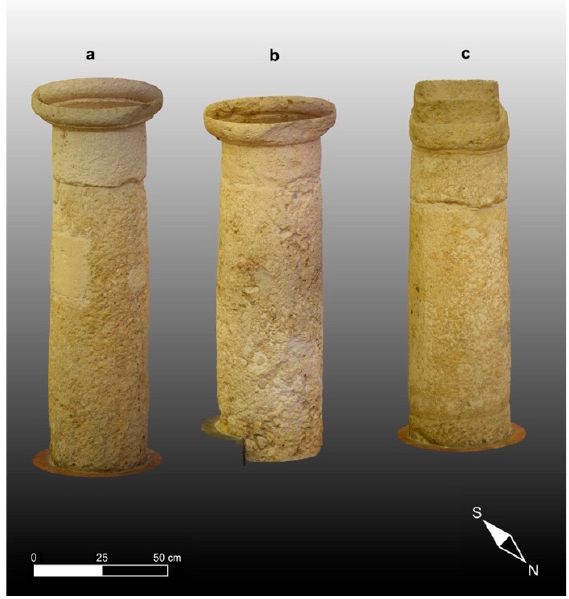
Figure 11. High-resolution 3D models of the three studied columns computed with CRP pho- togrammetry data processing and texturized with the natural colors of the high-quality 2D images: ( a ) Column 1; ( b ) Column 2; ( c ) Column 3.